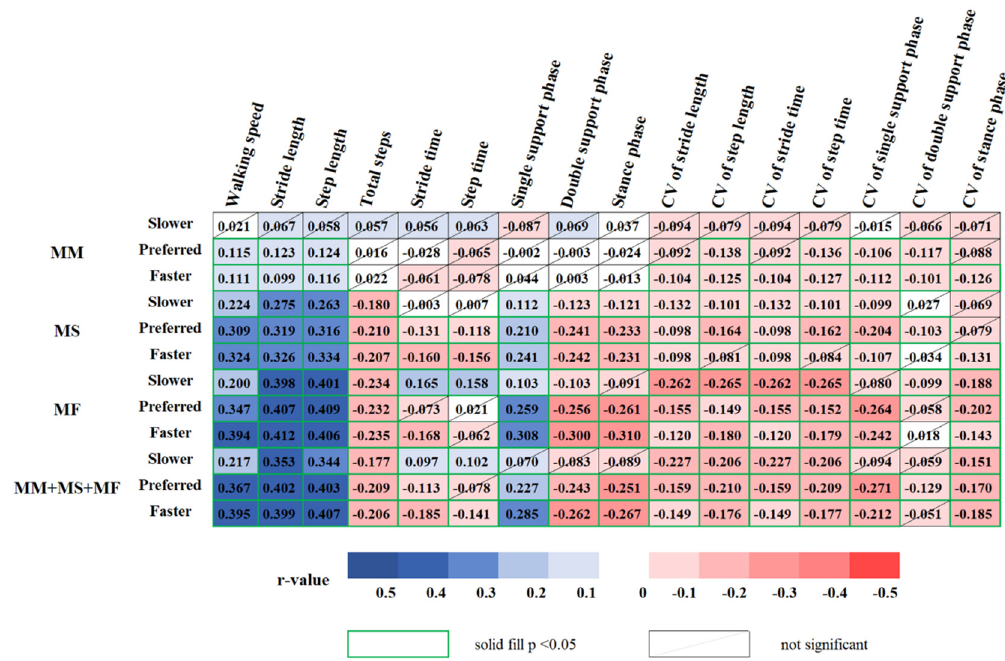
Figure 4. Correlogram representing the relationships between the MM-, MS-, and MF-related vari- ables and three speed-based gait variables in older women: blue represents positive correlation, and red represents negative correlation, while the non-significant results ( p < 0.05) are crossed out. MM: muscle mass; MS: muscle strength; MF: muscle function; CV: coefficient of variance. Table 2. Association of the gait variables at three different speeds with MM, MS, and MF-related